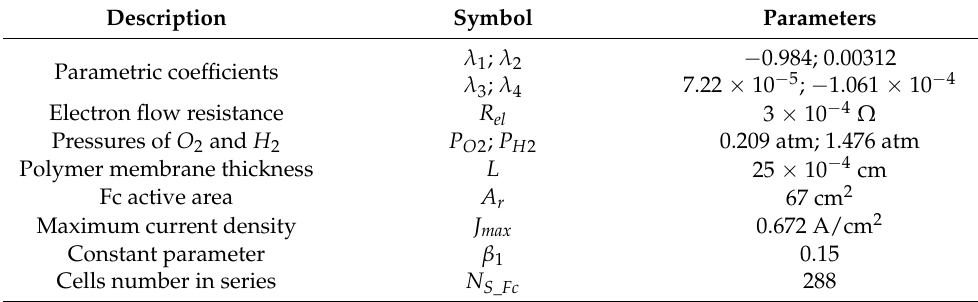
Table 1. Fuel cell parameters.